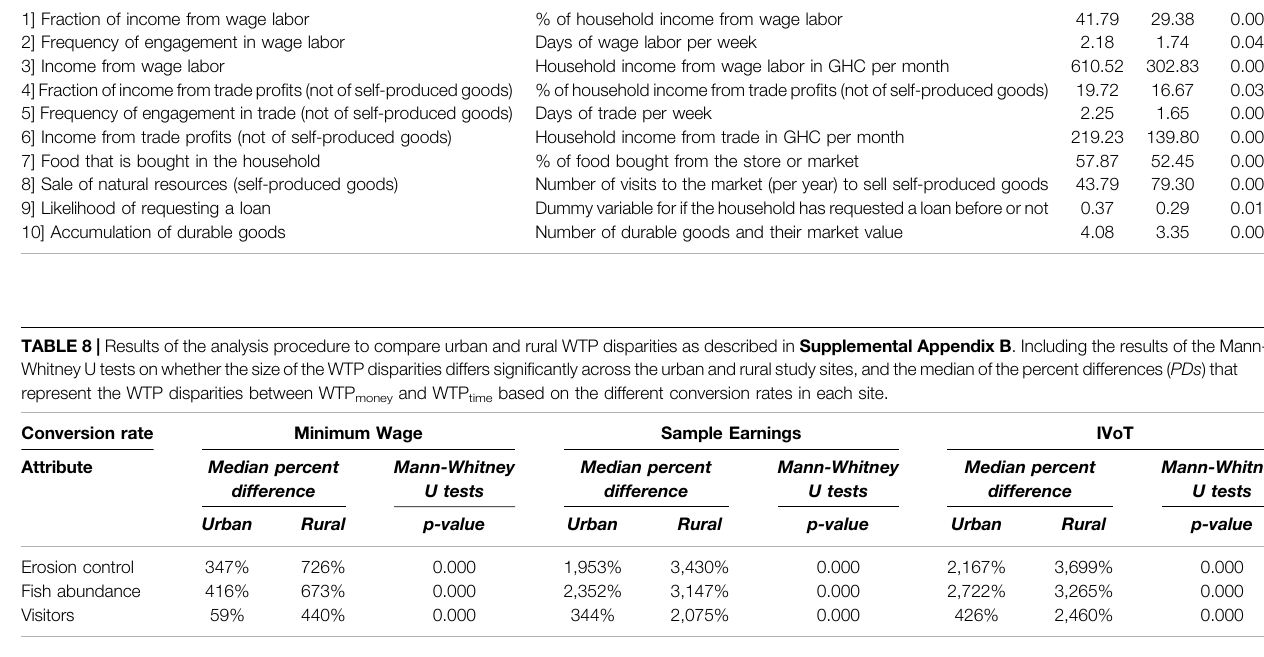
TABLE 7 | Results of the comparison of market integration measures across the urban and rural study site, analysed through Kruskal-Wallis and Chisquare tests Market integration measure